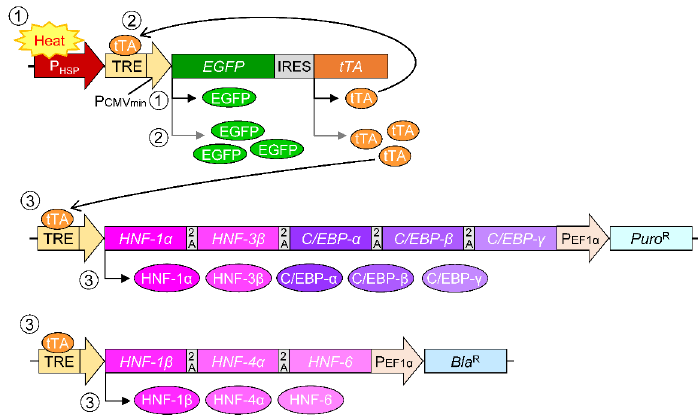
Figure 1. Schematic representation of the heat-inducible expression of liver-enriched transcription factor (LETF) genes mediated by artificial transactivator (tTA) with a positive feedback loop of tTA expression. (1) The heat shock protein 70B ’ (HSP70B’) promoter is activated by heat treatment and induces the expression of enhanced green fluorescent protein (EGFP) and tetracycline-responsive artificial transactivator (tTA). (2) tTA binds to the tetracycline repressor protein-response element sequence (TRE) to activate cytomegalovirus minimum promoter (P CMVmin ), which induces further tTA expression, establishing a transcriptional positive feedback loop. (3) The amplified tTA also promotes the expression of liver-enriched transcription factor (LETF) genes under the control of the TRE/P CMVmin promoter. LETF genes linked by a 2A peptide sequence are co-expressed by a single promoter. To select the transduced cells, the two vectors included a puromycin resistance ( Puro R ) gene and a blasticidin resistance ( Bla R ) gene under the control of the elongation factor 1 alpha (EF1α) promoter. IRES, internal ribosomal entry site; HNF, hepatocyte nuclear factor; C/EBP, CCAAT/en- hancer binding protein. 2. Materials and Methods 2.1. Cell Culture HepG2 and engineered HepG2 cells were cultured in high- glucose Dulbecco’s mod- ified Eagle’s medium ( DMEM) (Sigma-Aldrich, St. Louis, MO, USA) supplemented with 10% fetal bovine serum (FBS) (Biowest, Nuaillé, France), antibiotics (100 U/mL potas- sium penicillin G and 0.1 mg/mL streptomycin sulfate) (Fujifilm Wako Pure Chemical, Osaka, Japan), and 3.7 mg/mL NaHCO 3 (Fujifilm Wako Pure Chemical). Cells were cul- tured at 37 °C in a 5% ( v / v ) CO 2 incubator. For monolayer culture, cells were seeded into collagen-coated 24-well plates (AGC Techno Glass, Shizuoka, Japan) at a density of 4.0 × 10 4 cells/well. The next day (day 0), cells were subjected to heat treatment. The medium was changed every other day, and the harvested medium was applied for liver function analyses. To fractionate EGFP-positive cells, cells were seeded into collagen-coated 100-mm dishes (AGC Techno Glass) and exposed to heat treatment when the cell density reached 80% confluency. The next day (day 0), the cell population with high EGFP fluorescence intensity was sorted using an SH800 cell sorter (Sony, Tokyo, Japan). Cells were cultured at 1.0 × 10 5 cells/well in collagen-coated 24-well plates for monolayer culture, or at 2.3 × 10 4 or 4.7 × 10 4 cells/well (50 or 100 cells/microwell) in EZSPHERE SP 24-well plates (AGC Techno Glass) for spheroid culture. The culture medium was replaced with fresh medium every other day. To replace the entire culture medium for spheroid cultures, the spheroids